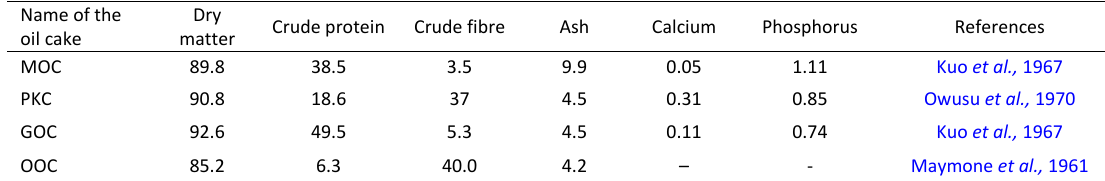
Table 4: Oil cake properties